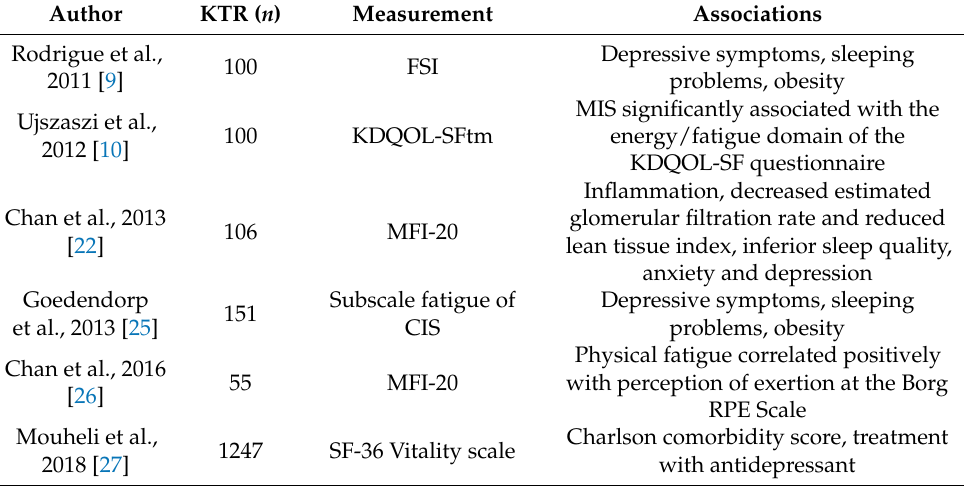
Table 2. Variables associated with fatigue in kidney transplant recipients (KTRs). FSI, Fatigue Symp- tom Inventory; KDQOL-SFTM, Kidney Disease Quality of Life Short Form; MFI-20, Multidimensional Fatigue Inventory-20; CIS, Checklist Individual